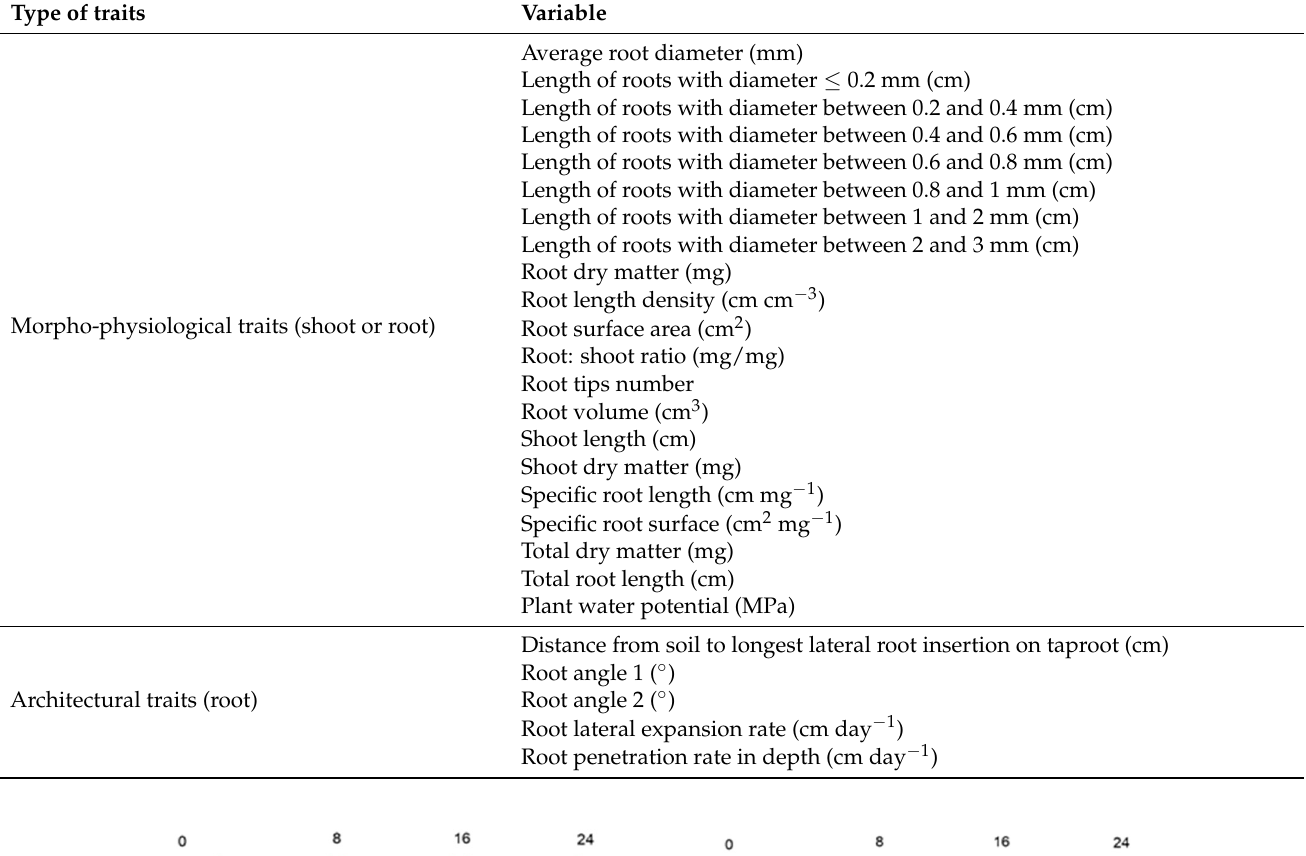
Table A2. Shoot and root morpho-physiological and root architectural traits for the phenotyping methods. Type of traits